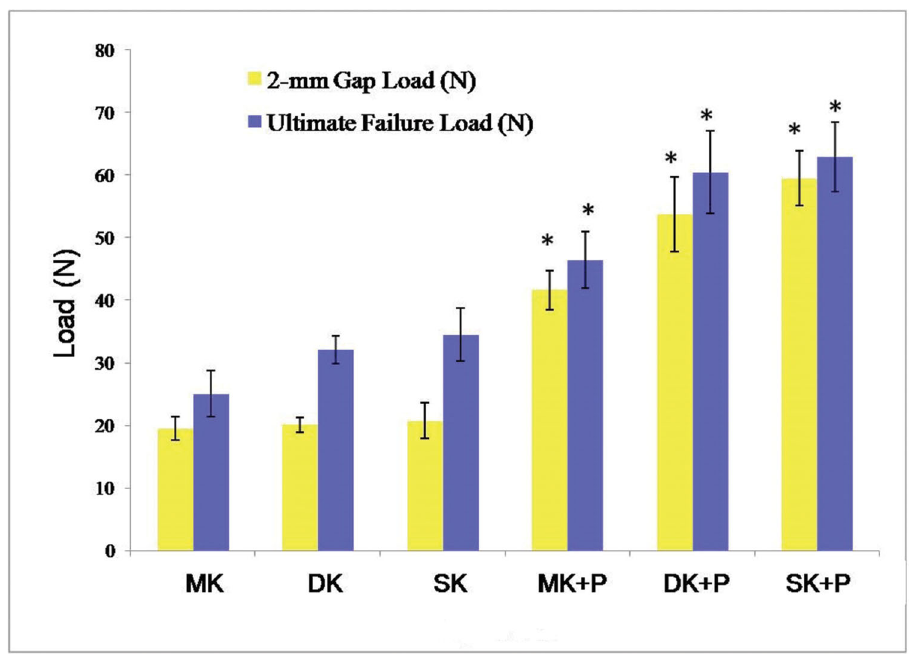
Figure 3 - The 2-mm Gap Load and Ultimate Failure Load of the six suture techniques. In comparison with single core suture method, the combination of core and epitendinous sutures withstood a significantly increased 2-mm Gap Load and Ultimate Failure Load. Error bars represented the SD from eight porcine flexor tendons. p o 0.05 versus core suture, respectively. MK, modified Kessler suture without epitendinous suture; DK, double knot Kessler-loop lock flexor tendon suture without epitendinous suture; SK, single knot Kessler-loop lock flexor tendon suture without epitendinous suture; MK + P, modified Kessler suture with epitendinous suture; DK + P, double knot Kessler-loop lock flexor tendon suture with epitendinous suture; SK + P, single knot Kessler-loop lock flexor tendon suture with epitendinous suture; SD, standard deviation.